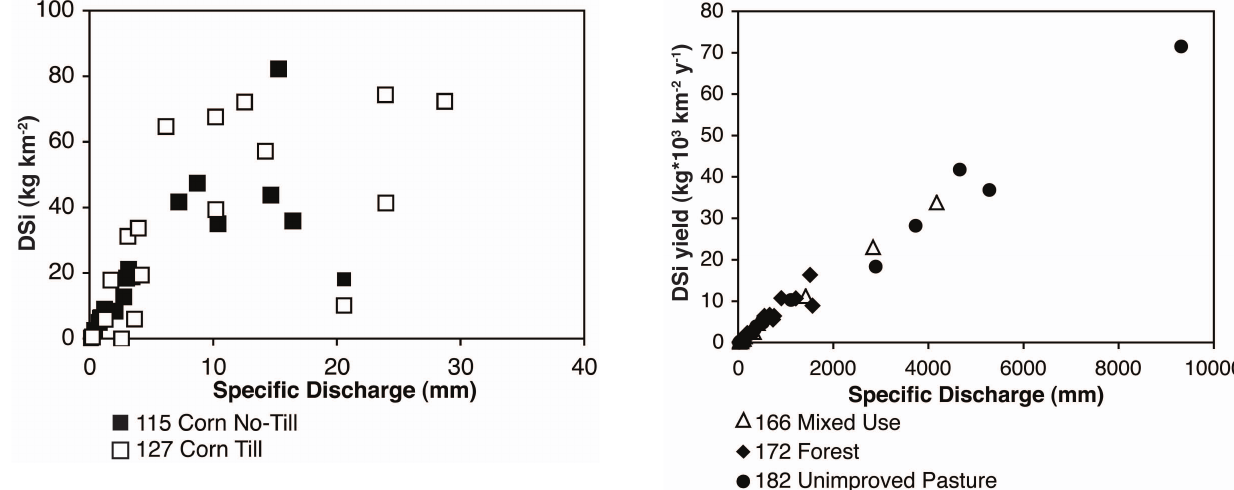
Fig. 5. Dissolved silica yields from corn watersheds 115 and 127 for individual storms plotted with specific discharge (mm) associated with individual storms.